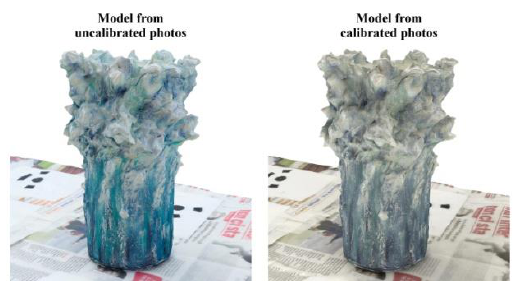
Figure 7. Comparison between the textured three-dimensional models of the vase.